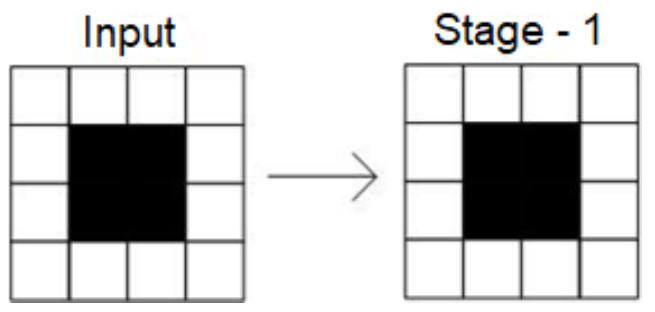
Figure 4. Variant of the initial filling of the data set.